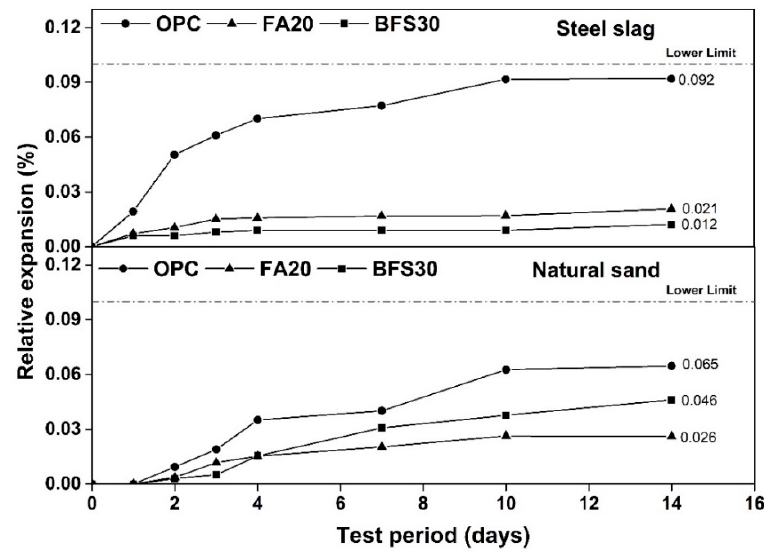
Figure 3. Results of ASR expansion test (mortar bars).